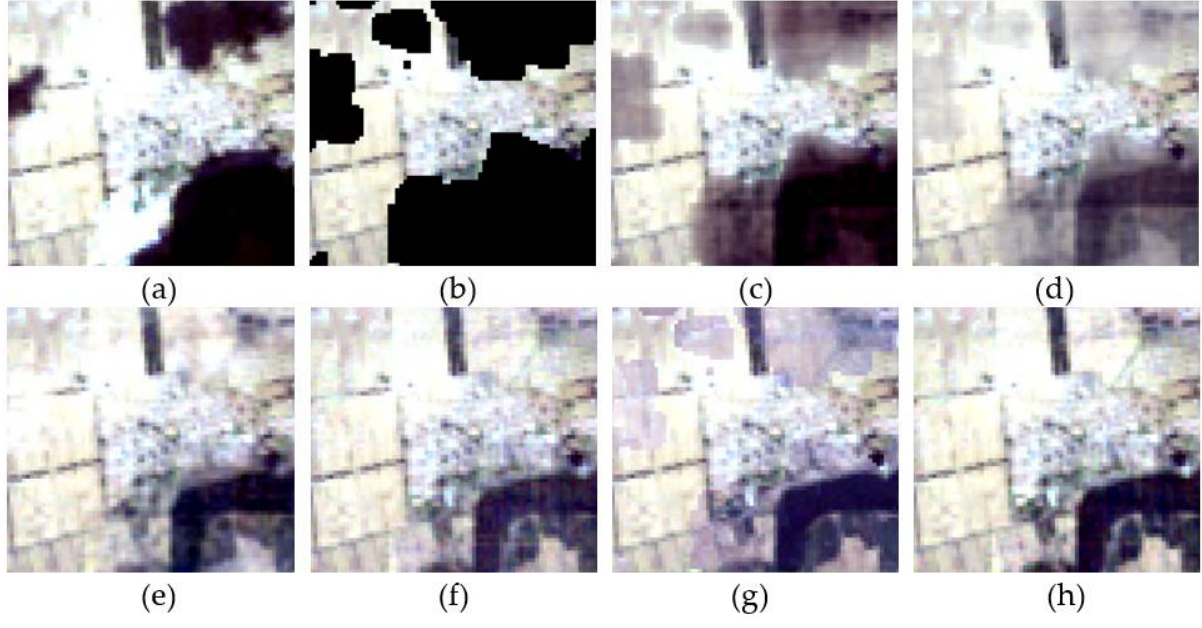
Figure 17. Enhanced details from Figure 16a–h: ( a ) original image; ( b ) masked image ( c – h ) recon- structed images of HaLRTC, AWTC, NL-LRTC, TVLRSD, ST-Tensor and FMTC algorithms, respec- tively.